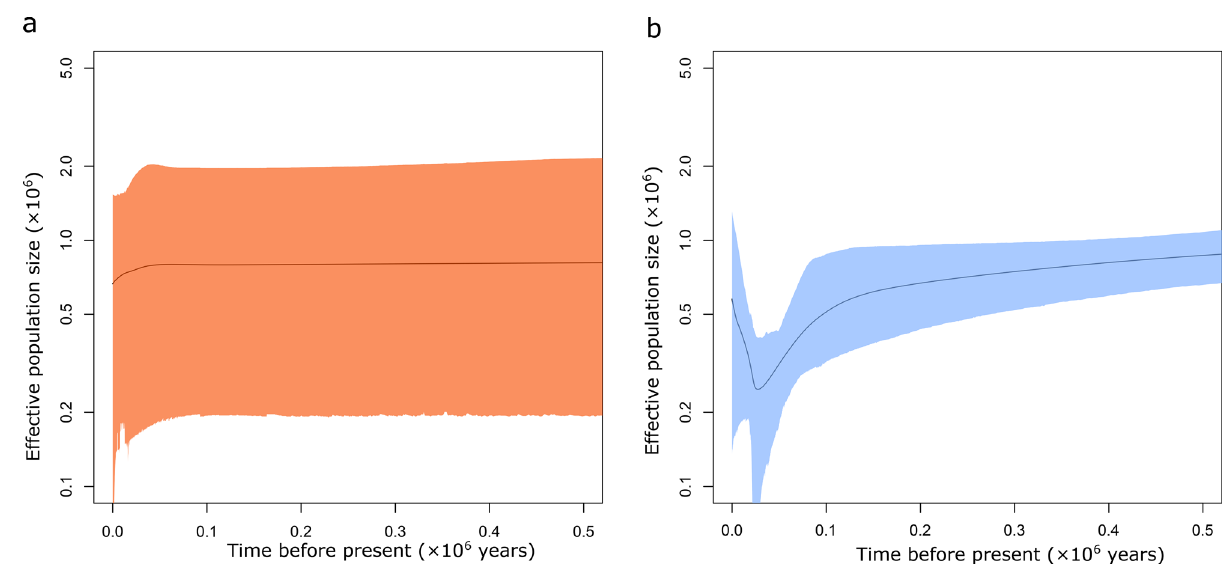
Figure 4. Effective population size of C. falcatum subsp. australe (a) and subsp. littorale (b) in chronological order estimated by Extended Bayesian Skyline Plot. The x-axis is time in million years before present. The y-axis is the effective population size in million individuals. The 95% confidence interval is filled red (a) and blue (b)